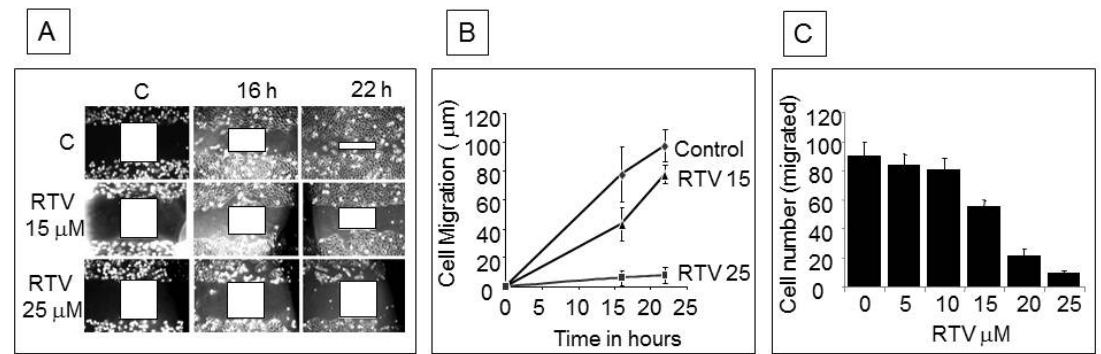
Figure 5. Wound healing and cell migration assays in PANC-1 cells: ( A ) Cell motility in wound healing assay. A uniform scratch was made in an 80% confluent monolayer culture and the extent of closure was monitored under phase-contrast microscopy and photographed. Representative images of two independent experiments done in duplicate are shown;